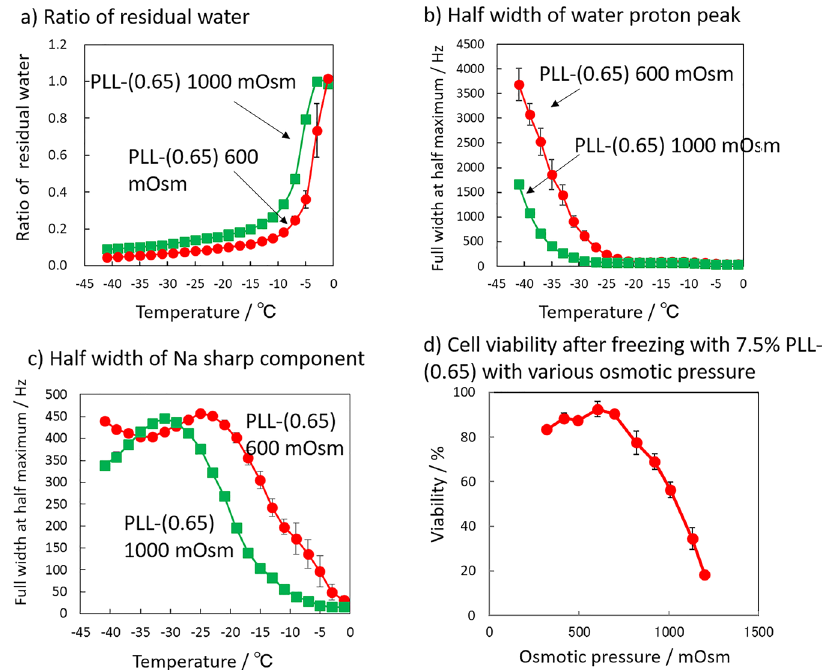
Fig. 4 Effect of a high salt concentration on the water, Na-ion behavior, and cryopreservation. a – c Temperature-dependent a ratio of residual water, full width at half maximum values for b the water proton peak, and c the Na sharp component signals of 600 and 1000 mOsm PLL-(0.65) solutions. d the cell viability after freezing with 7.5% PLL-(0.65) using various osmotic pressures. Error bars represent standard